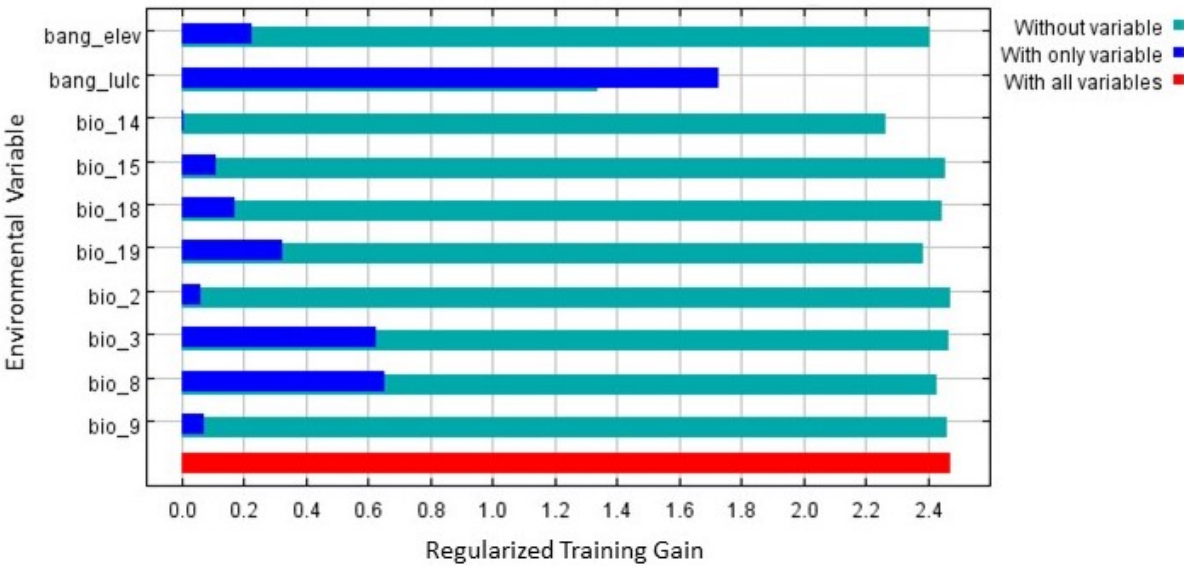
Figure 2. Jackknife evaluation of the relative importance of the environmental variables and their contribution to the MaxEnt model.